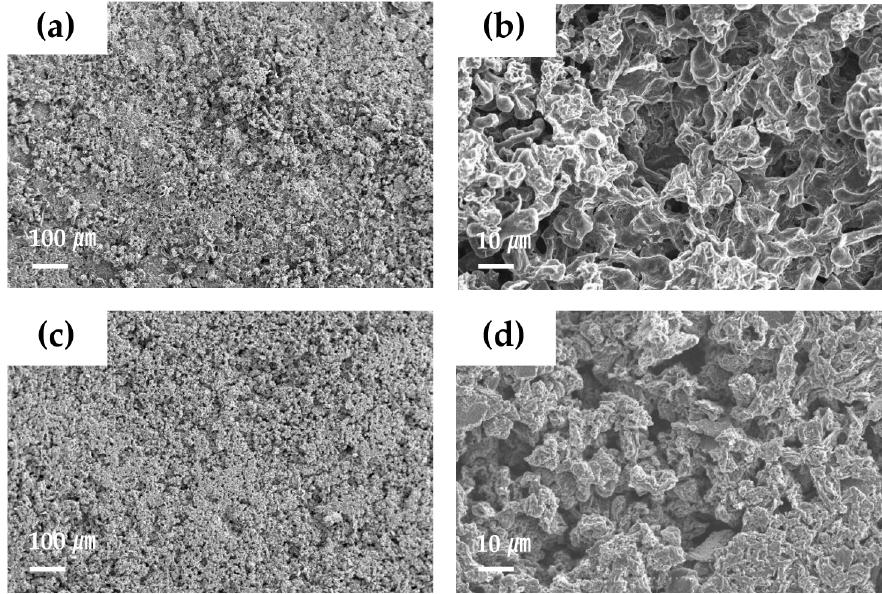
Figure 6. SEM images of the Li metal electrode surface after the Li deposition/dissolution cycling test for the Li/Li symmetric cell ( a , b ) with the PE separator and ( c , d ) with the LICGC/PEO/LiTFSI-coated PE separator.